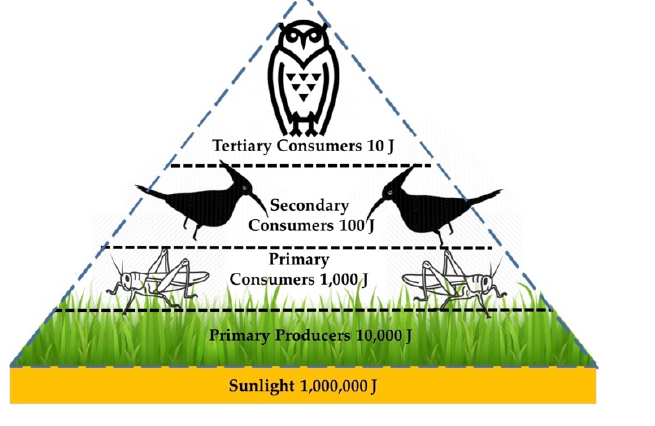
Fig. 2 . Illustration of Lindeman’s 10%